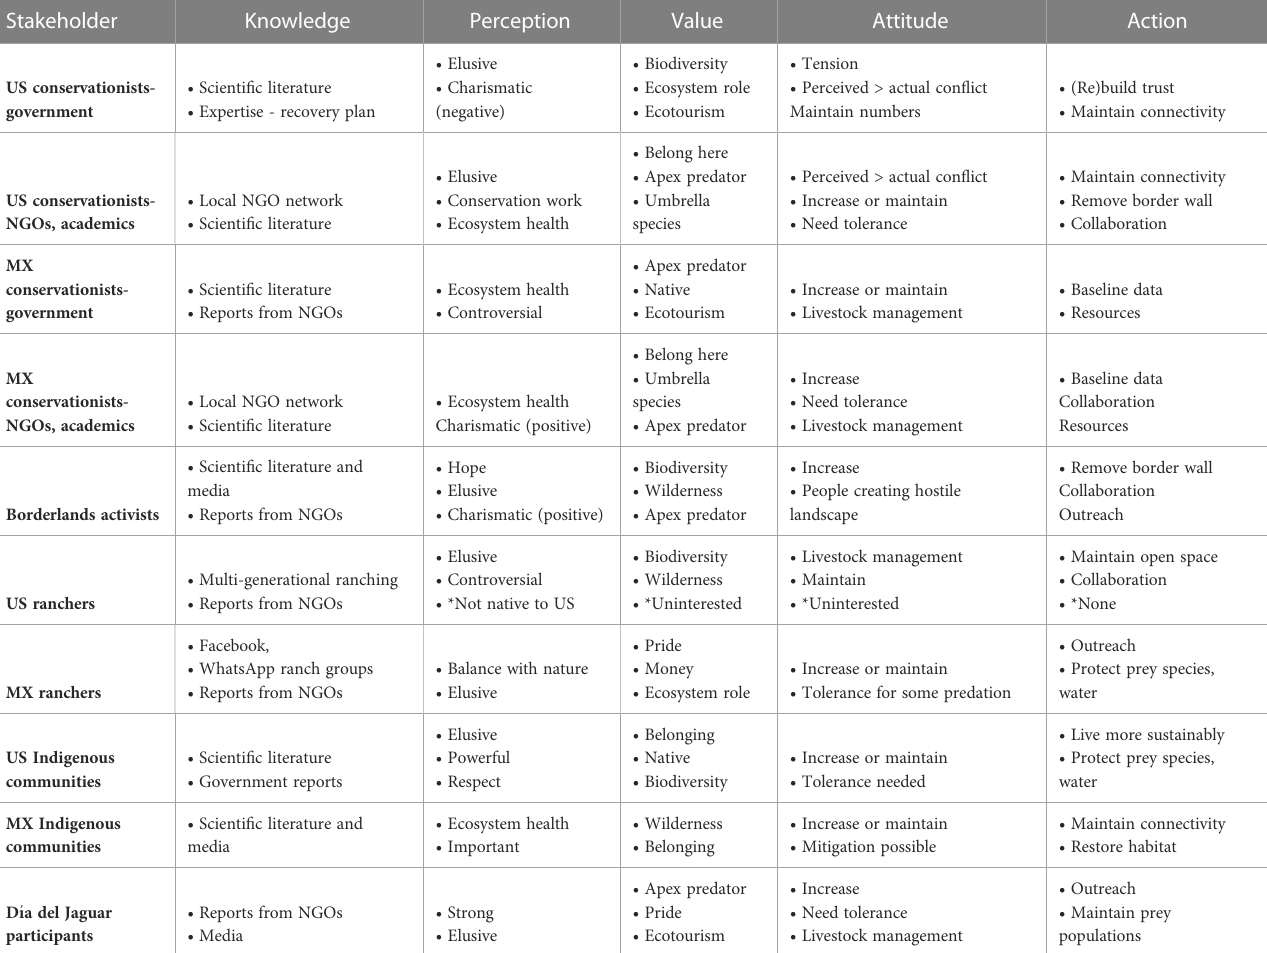
TABLE 2 Summary characteristics of each stakeholder ’ s natural reality of borderland jaguars.